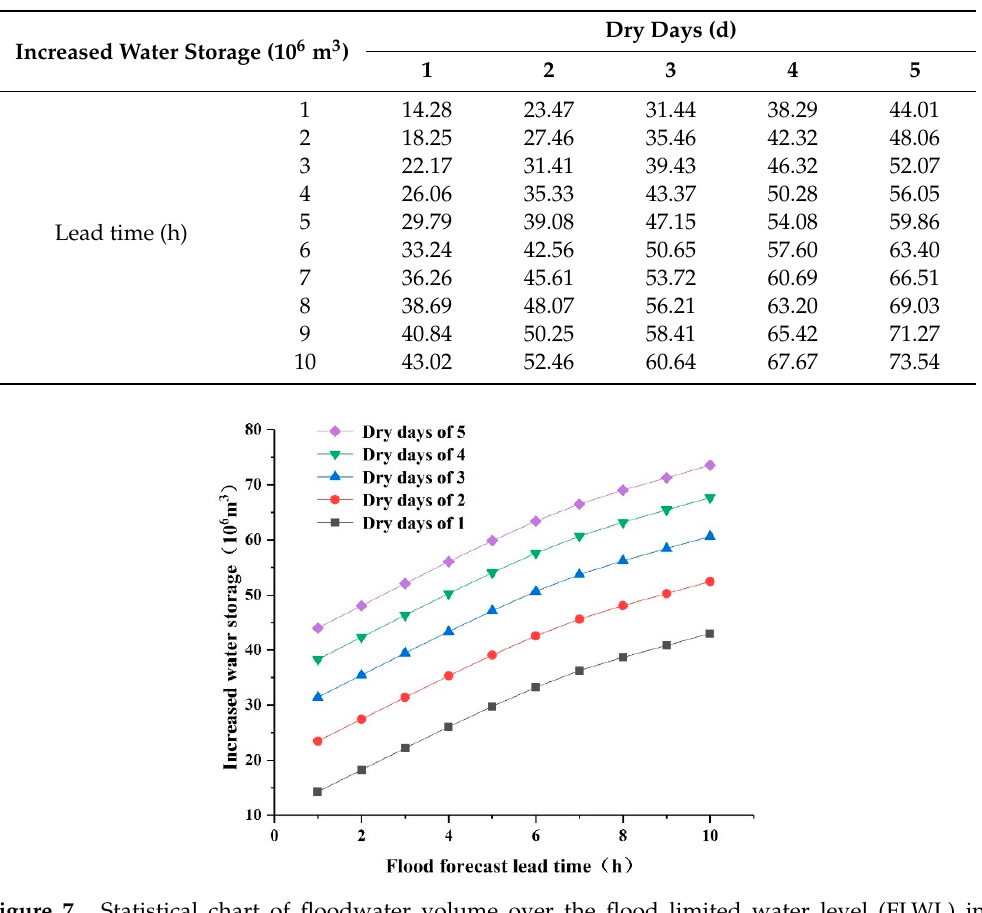
Table 4. Increased water storage in di ff erent scenarios.